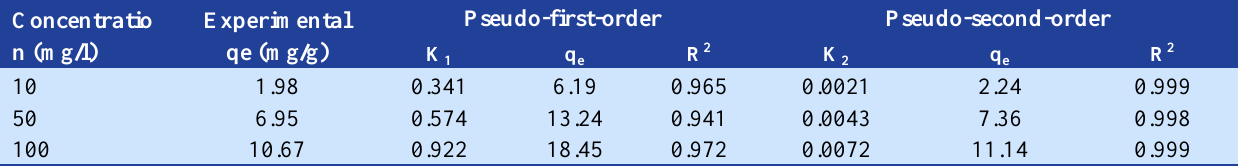
Table 2. Kinetic parameters for the adsorption of Cr (VI) onto canola at various concentrations Concentratio Experimental n (mg/l) qe